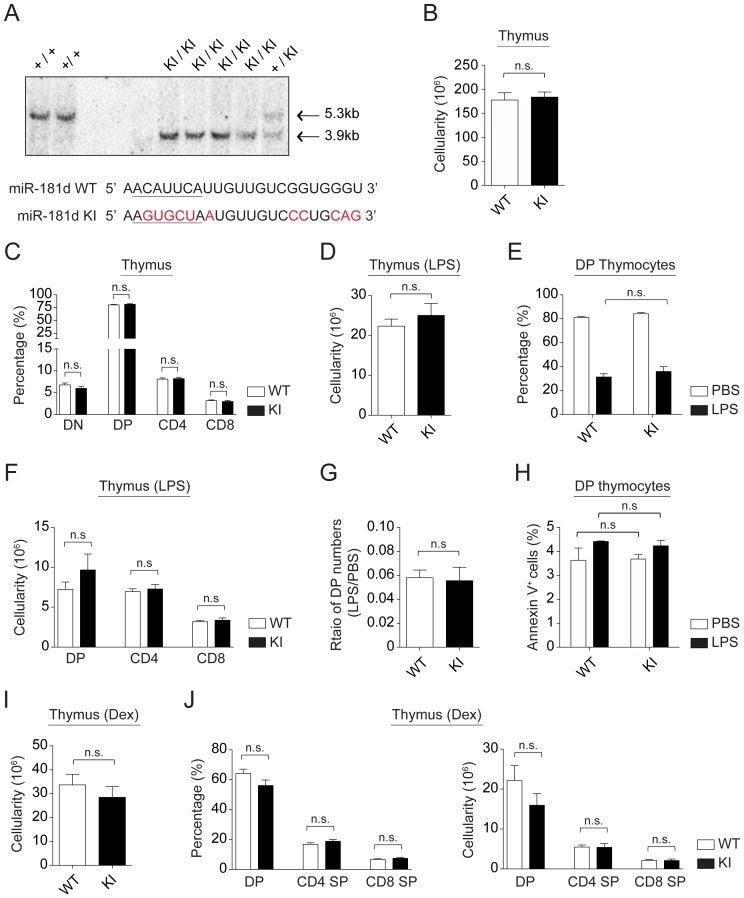
T cell development is normal in miR-181d knock-in mice.(A) Confirmation of miR-181d KI by a representative southern blot. Comparison of the wild type and mutated (miR-181d KI) sequences are provided. 5′-seed region is underlined. Base replacements are highlighted in red. (B) Total thymus cellularity in the control and miR-181d KI mice. (C) Average percentages of thymocyte subsets (DN, DP, CD4 SP, and CD8 SP) are shown for the WT (white) and miR-181d KI (black) mice. (B–C) Data are of the mean +/− SEM from the WT (n = 18) and miR-181d KI (n = 17) mice. (D) Total thymus cellularity in the control and miR-181d KI mice at 72 hours post-LPS (100 µg/mouse) injection (n.s.  =  non-significant; Two-tailed unpaired Student's t-test). (E) Average percentages of DP thymocytes at 72 hours after PBS or LPS treatment (n.s.  =  non-significant; Two-way ANOVA followed by Bonferroni's post-hoc test). (F) Absolute cell numbers of thymocyte subsets at 72 hours post-LPS injection (n.s.  =  non-significant; Two-tailed unpaired Student's t-test). (D–F) Data show the mean +/− SEM at least 4 independent experiments using at least 3 mice per treatment. (G–H) Data were calculated from the experiments shown in the panels D and E. Each bar shows the mean +/− SEM. (G) Ratios of DP thymocyte numbers upon LPS treatment to the numbers of DP thymocytes upon PBS treatment (n.s.  =  non-significant; Two-tailed unpaired Student's t-test). (H) Average percentages of Annexin V+ cells gated on DP thymocytes at 72 hours post-injection (PBS, white; LPS, black). (n.s.  =  non-significant; Two-way ANOVA followed by Bonferroni's post-hoc test). (I) Total thymic cellularity in the control and miR-181d KI mice at 48 hours upon Dex injection (60 µg/mouse). (J) Average percentages (left) and absolute numbers (right) of thymocyte subsets following Dex treatment at 48 hours. (I–J) Bar graphs show the mean +/− SEM from at least 4 mice per treatment (n.s.  =  non-significant; Two-tailed unpaired Student's t-test).